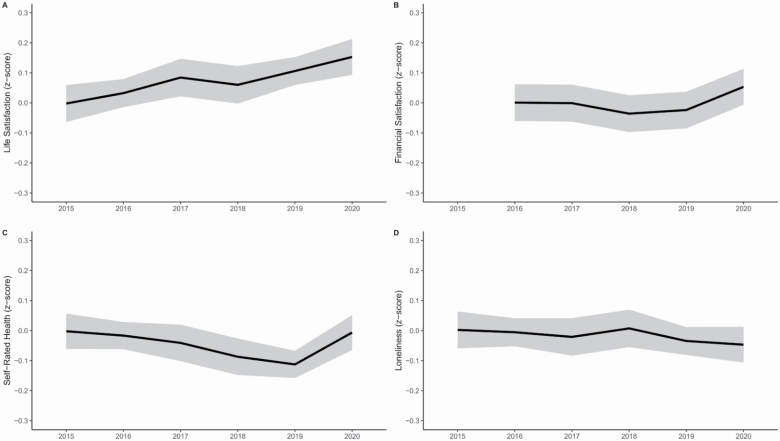
Yearly changes (2015–2020) in the four well-being domains: life satisfaction (A) showed a marginal but nonsignificant increase over time, financial satisfaction (B) was stable over time but increased in 2020, self-rated health (C) declined between 2015 and 2019 but increased in 2020, and loneliness (D) showed no change across years.